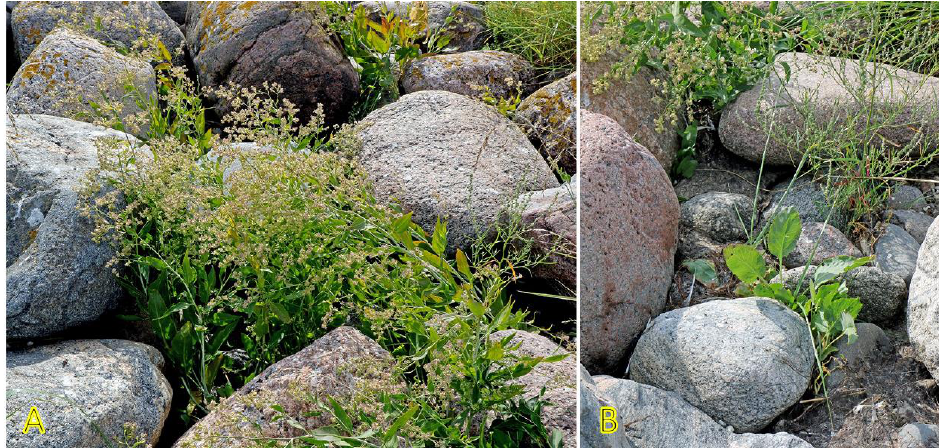
Figure 22. Lepidium latifolium plants on boulder beach on the island of Kihnu, Estonia. ( A ), established individuals; ( B ), young individual.